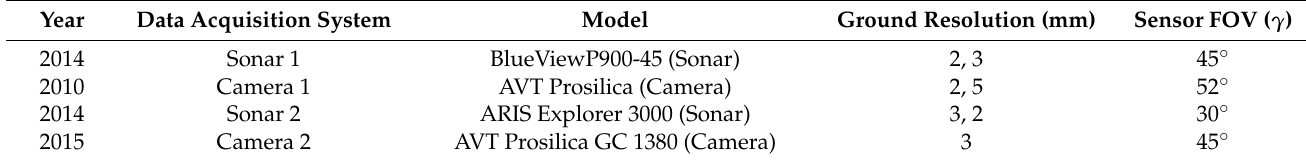
Table 1. Data acquisition characteristics summary. Data from [48,51].